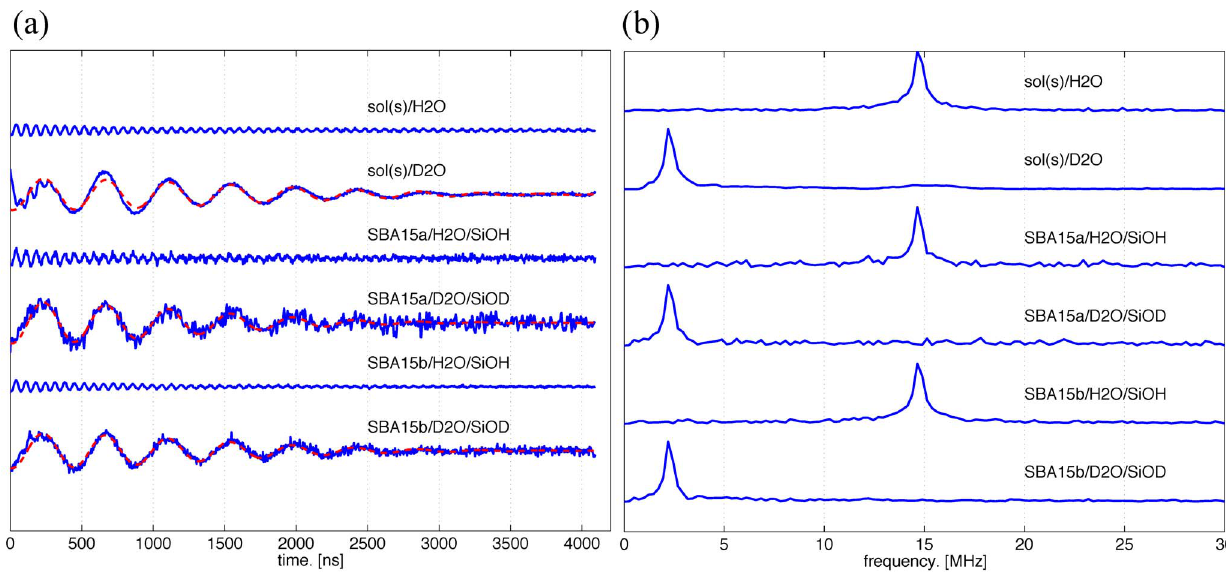
Figure 3. Water accessibility study of the n3 b -s by ESEEM. (a) Three-pulse ESEEM time-domain data (solid lines) after the removal of the exponential decaying function in the raw data. The modulation depth is directly correlated to the peak intensity of the FT-ESEEM and can be quantitatively described by k D and obtained in the following analysis. The dashed lines represent the theoretical fits to the experimental data. (cid:1) (cid:2) , as a function of the ESEEM collection time t , can According to ESEEM theory, a damped harmonic oscillation f t ð Þ ~ k D cos 2 pn D t z q ð Þ exp { t 2 = t 2 0 be employed. [20] The f ( t ) function was least-square fitted to the ESEEM time-domain data by varying the deuterium modulation depth, k D , damping constant, t 0 , and phase, w , while keeping the Larmor frequency of deuterium n D fixed. The best-fit parameters are shown in Table 1. The signal-to- noise ratio of the experiments varies with many experimental conditions, such as instrumental setups, data collection time, and so on. Thus, FT- ESEEM has been a typical data presentation for the ESEEM analyses. (b) The FT-ESEEM data for the n3 b -s in the studied conditions, including the vitrified bulk solvent and a variety of combinations of the nanochannel materials (SBA15a, SBA15b), solvents (H 2 O, D 2 O), and surface groups inside the materials (-SiOH or -SiOD).